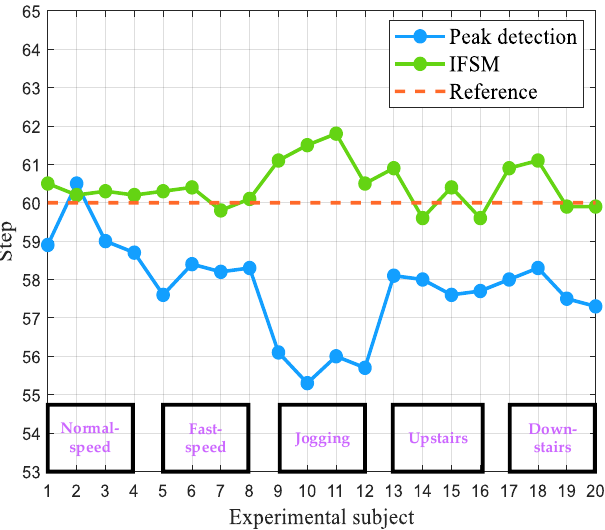
Figure 10. The comparison of gait detection. Table 3. Gait detection results of 20 experiments under different motion states. Experimental Motion State Subjects